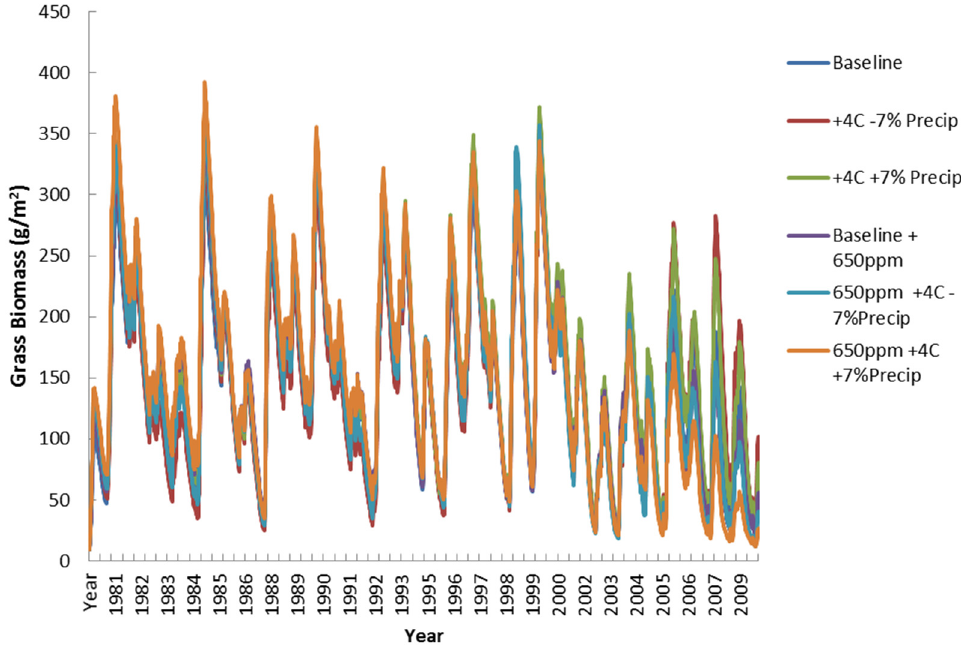
Figure 15. Simulated grass biomass (g/m 2 ) for all climate scenarios.